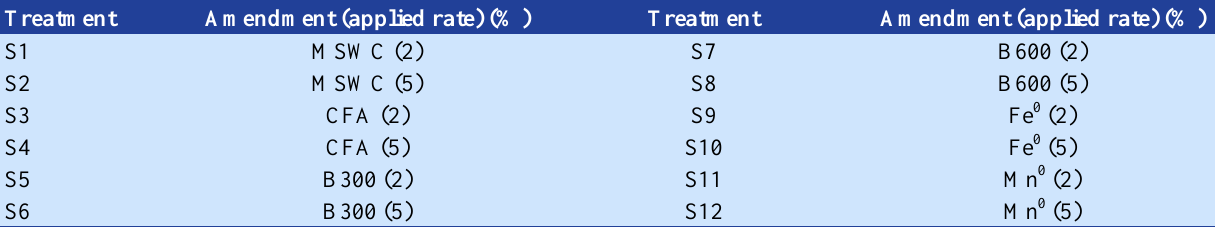
Table 3. Experimental design for incubation experiment Treatment